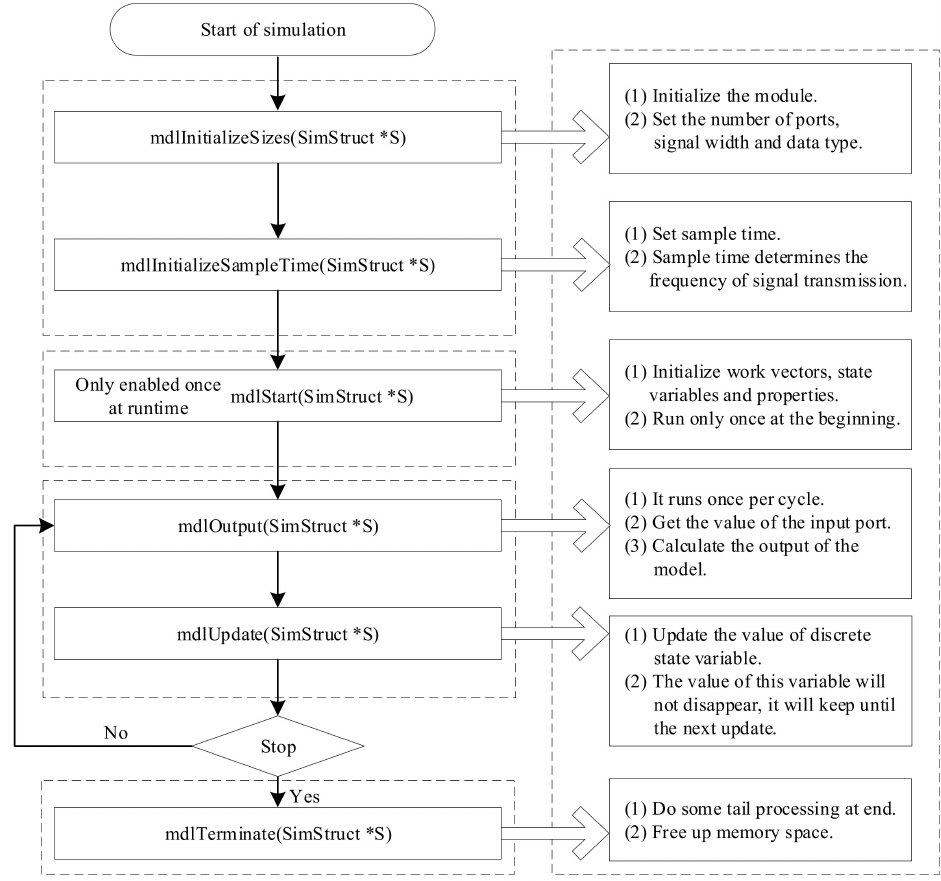
Figure 3. Design flow of device driver module based on